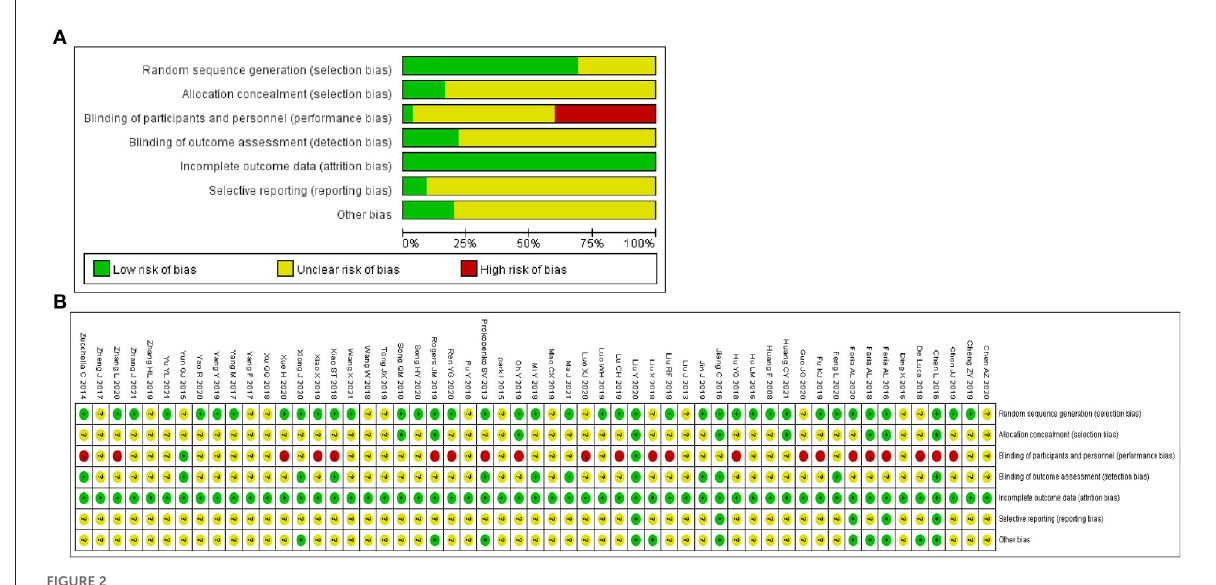
FIGURE2 Quality assessment of selected studies by the Cochrane risk of bias tool. (A) Risk of bias graph: review authors’ judgments about each risk of bias item presented as percentages across all included studies. (B) Risk of bias summary: review authors’ judgments about each risk of bias item for each included